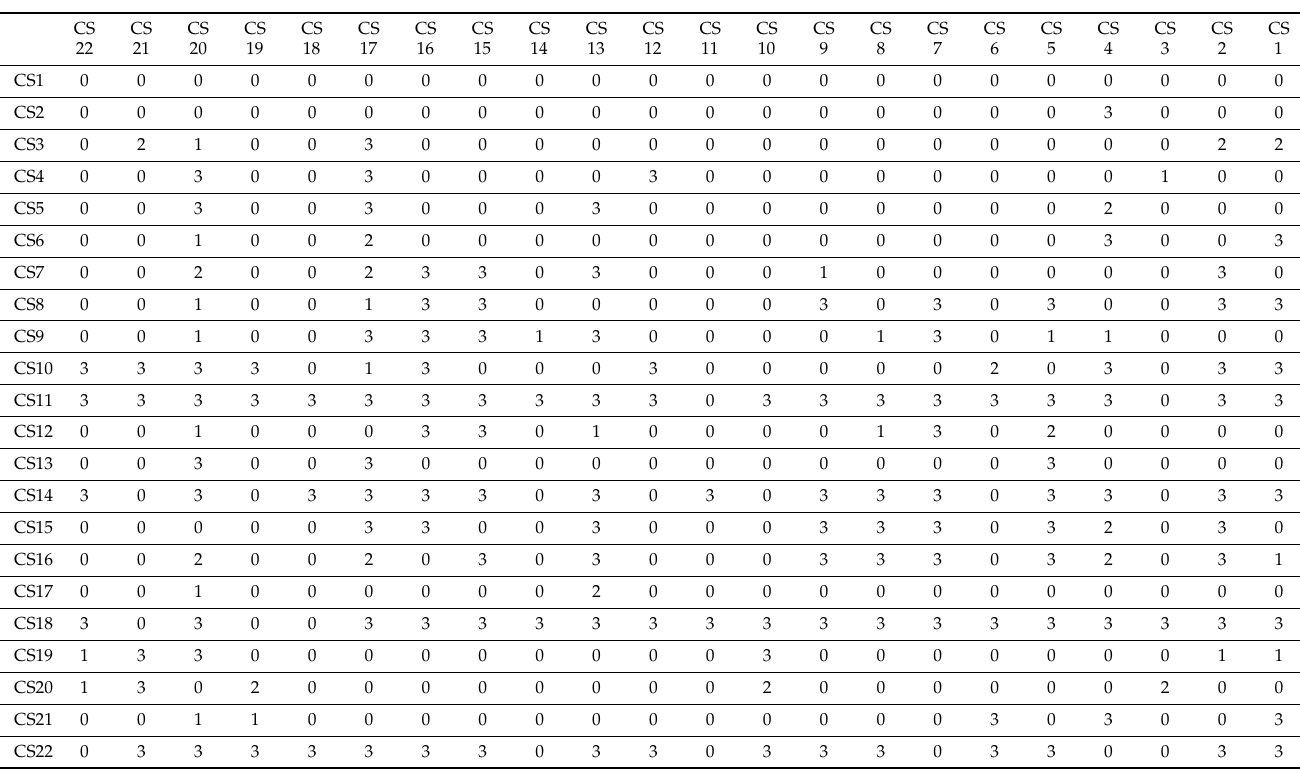
Table A4. Direct effect